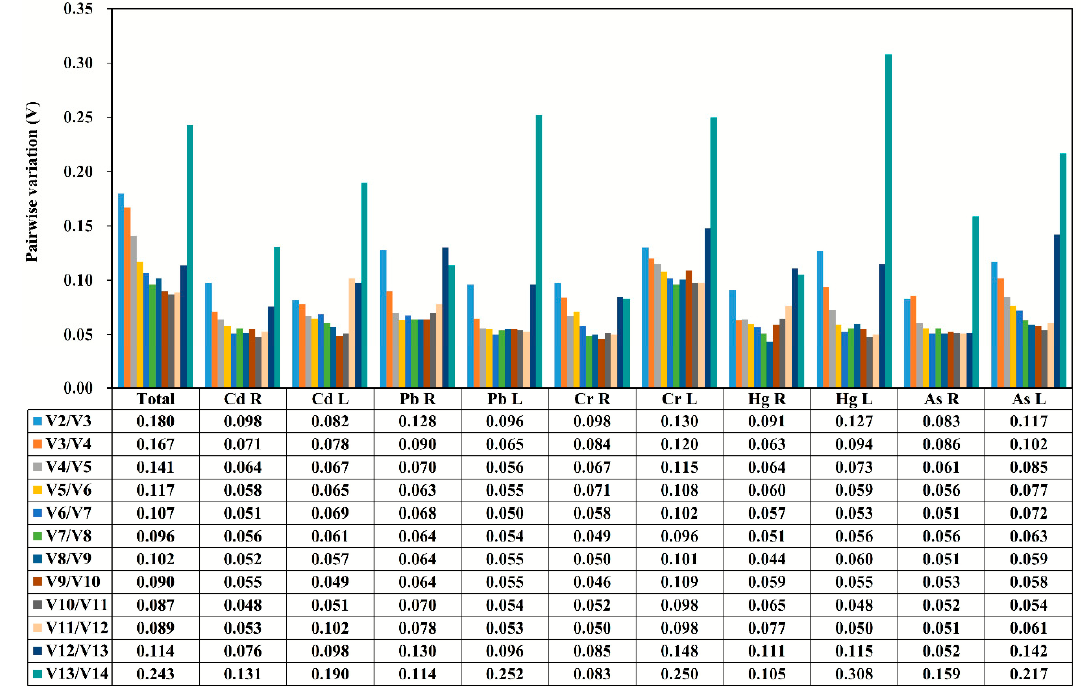
Figure 3. The pairwise variation (V) measure of the candidate reference genes using GeNorm. V n / V n + 1 values were used to calculate the optimal number of reference genes ( n ).